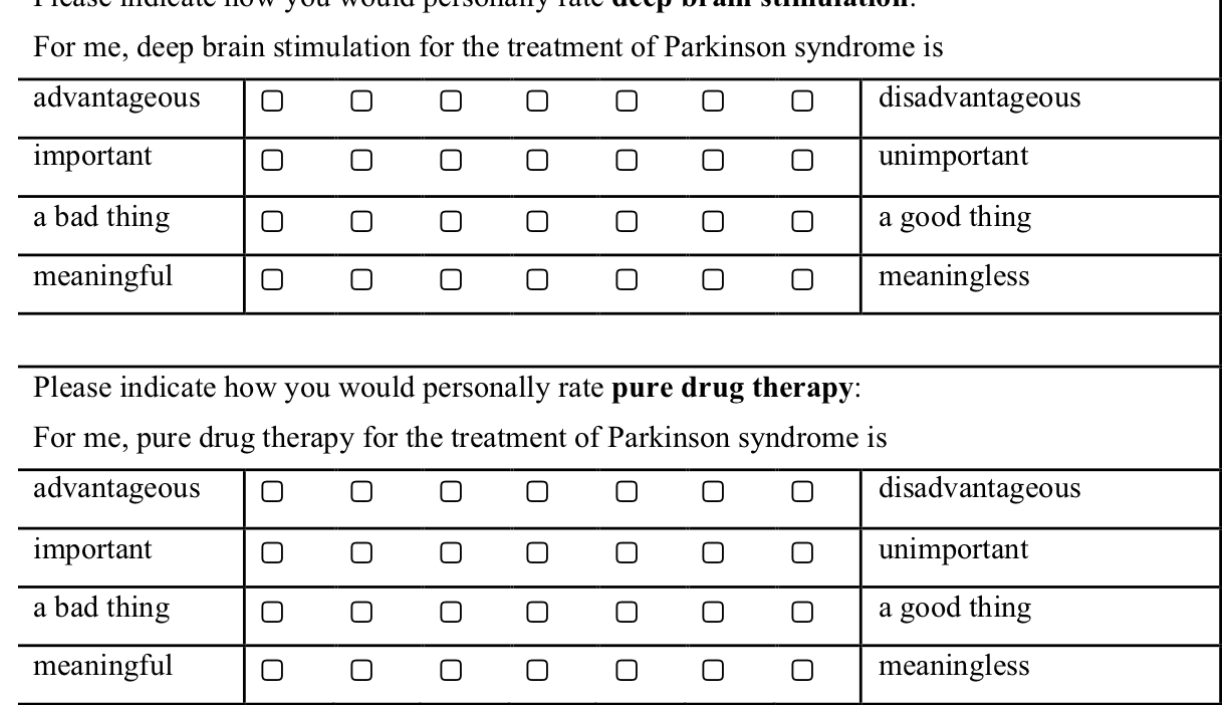
Figure 2. Preparation for decision making